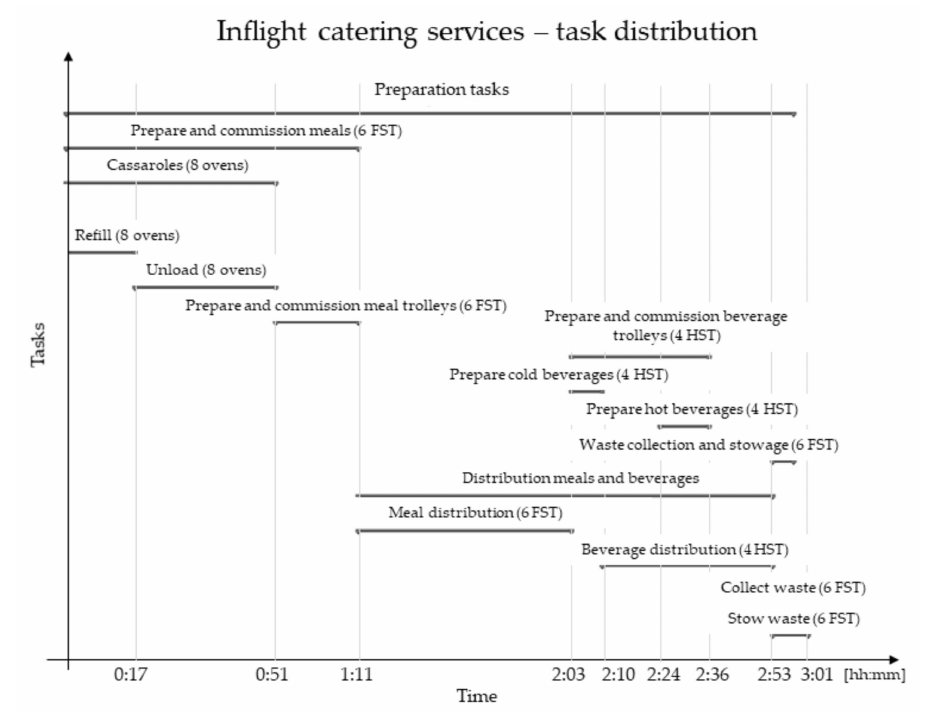
Figure 11. Example inflight catering service (e.g., lunch) for a long-range flight of 10 h, with 226 pas- sengers and 4 flight attendants.